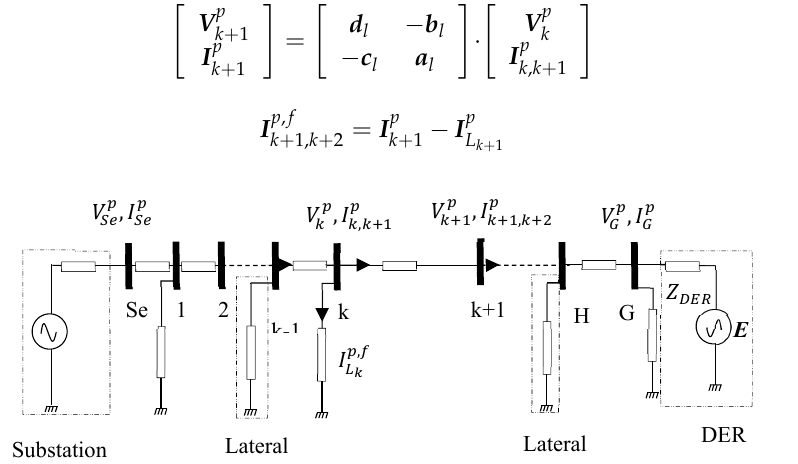
Figure 5. Estimation of the internal voltage in the model of the synchronous generator.